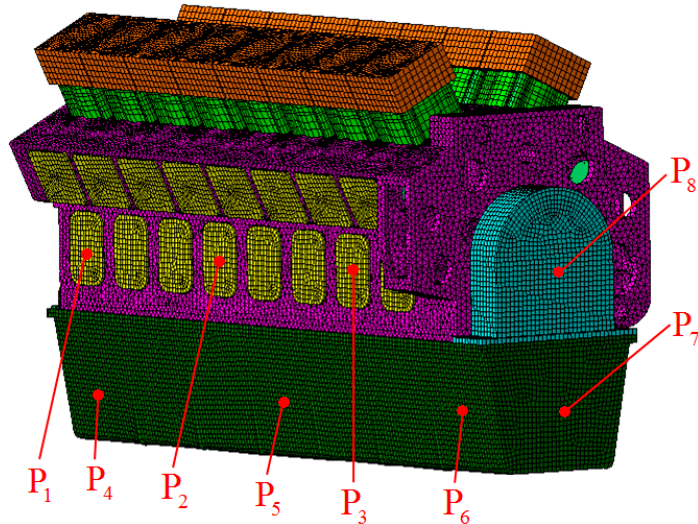
Figure 4. Finite element FE model of the diesel engine.